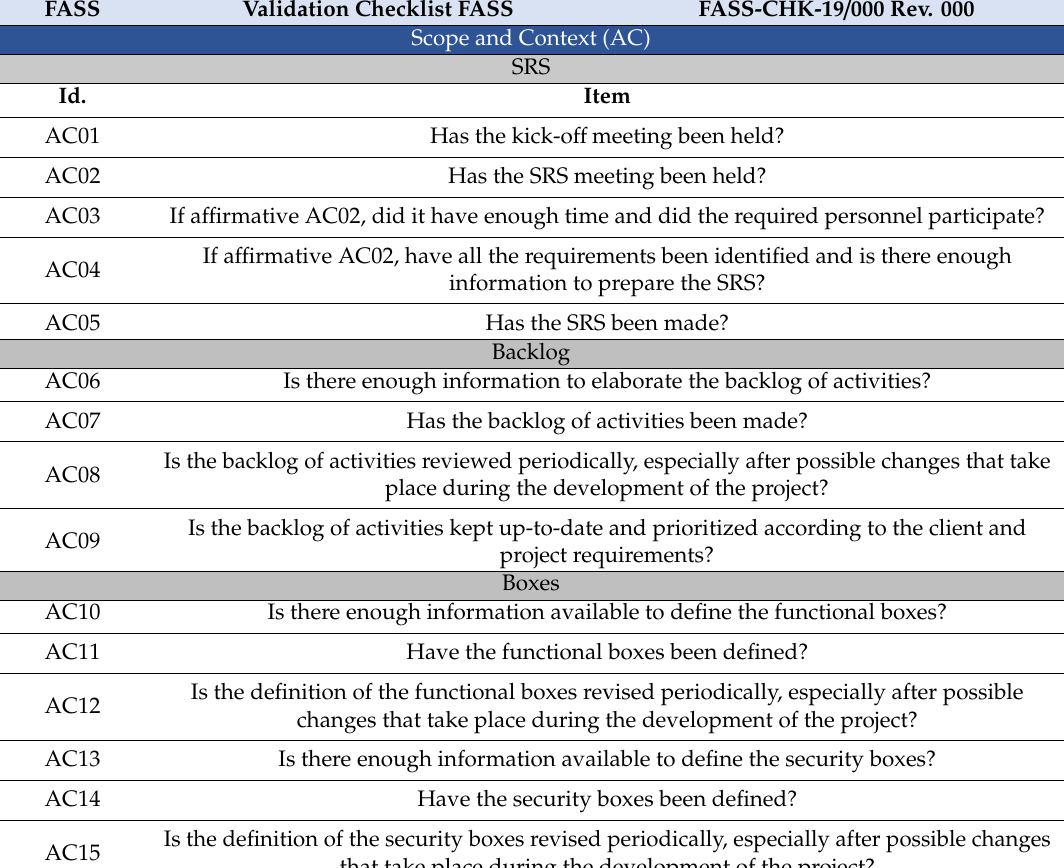
Table 6. FASS (Flexible Agile Secure Software)